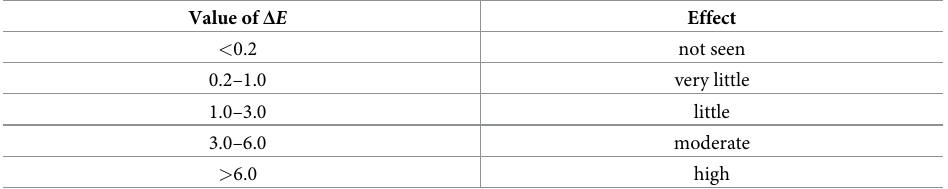
Table 1. Classification of the color difference between before and after test.